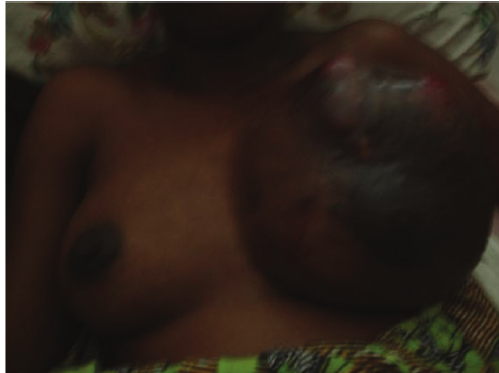
Table 3: Distribution of the breast cancer patients by Clinical TNM classification.